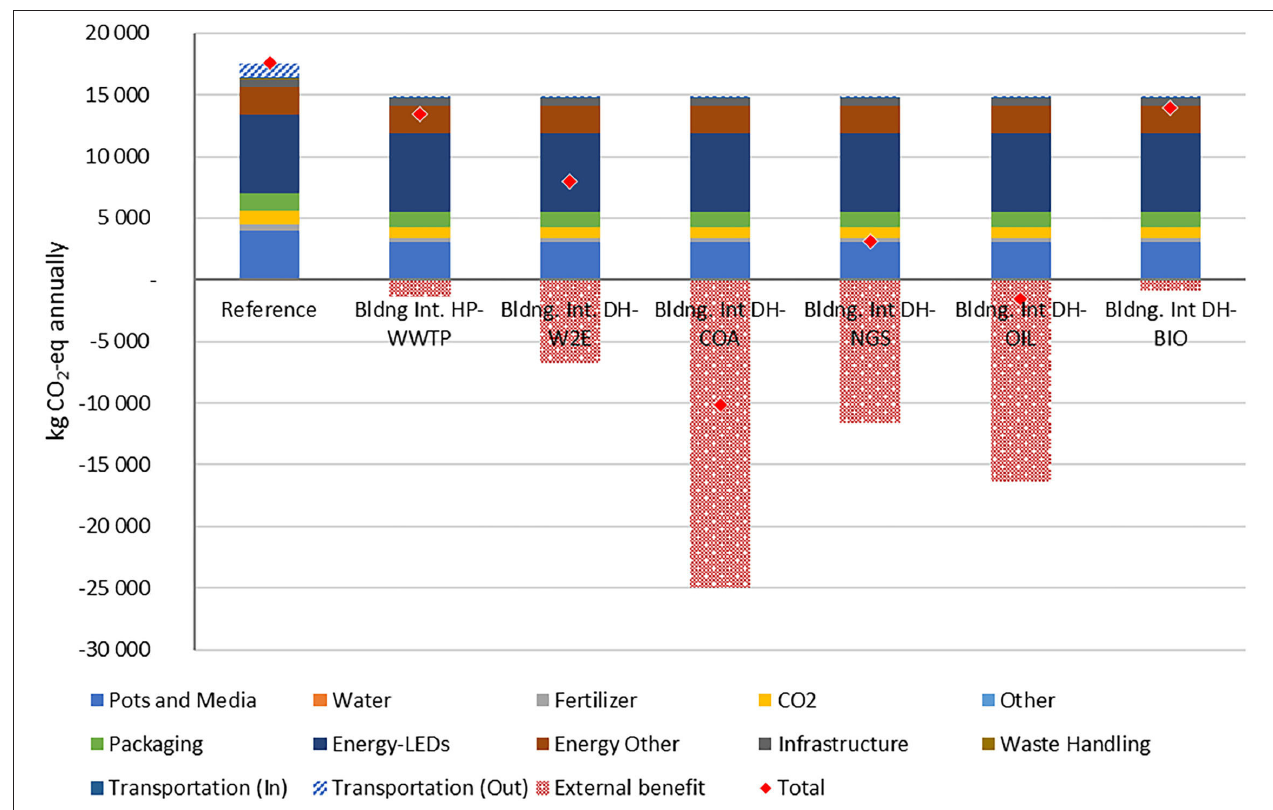
FIGURE 6 | Illustration of the sensitivity to choices made on the annual GHG emissions for the Bldng Int- scenarios, illustrating the contribution of different processes. Additional scenarios describe district heating from the co-production of electricity and heat in typical power plants fuelled by coal (COA), natural gas (NGS), oil (OIL) or biomass (BIO).